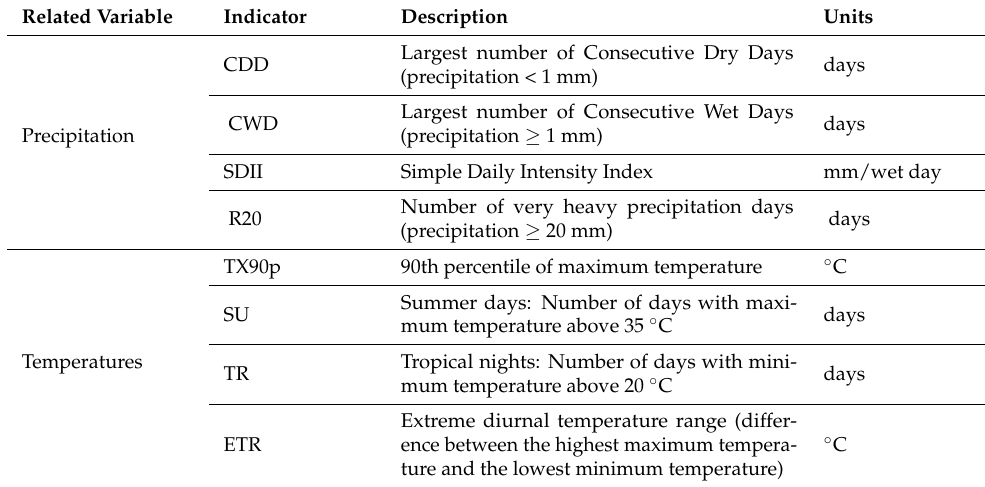
Table 3. Precipitation and temperature-based extreme indicators